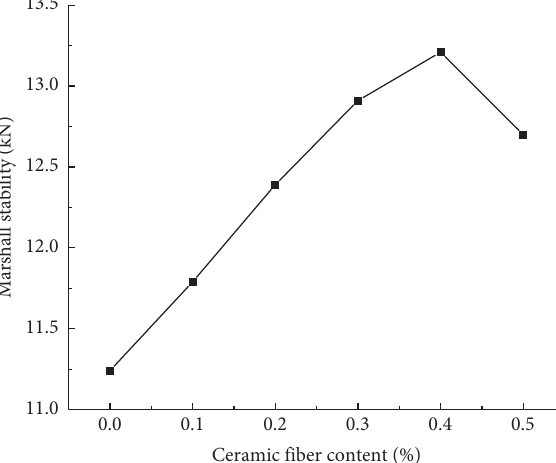
Figure 4: Relation between bulk specific gravity and CF content.